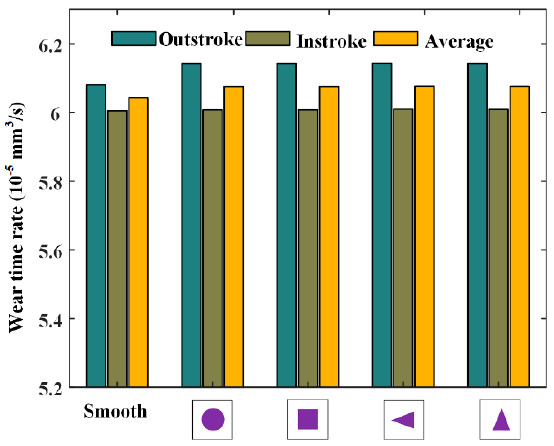
Figure 15. Wear time rates of different textures.